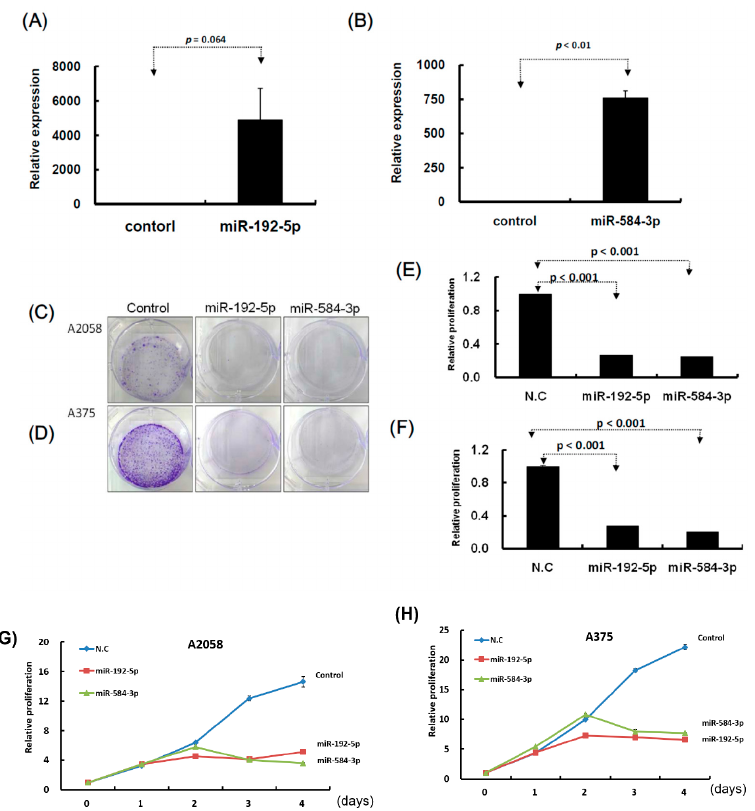
Figure 4. Growth of melanoma cells was suppressed after transfection of miR-192-5p and miR-584-3p mimics candidates. ( A ) and ( B ): After transfection of miRNA mimics, the relative expression levels of miR-192-5p and miR-584-3p were examined through real-time PCR. ( C ) and ( D ): After miR-192-5p, miR-584-3p, and control, respectively, were transfected into melanoma cells, the cells were incubated for two weeks and the colony was examined with crystal violet. ( E ) and ( F ): Relative colony formation ability was quantified using OD595 nm. ( G ) and ( H ): Proliferation of melanoma cells with or without miR-192-5p or miR-584-3p overexpression was examined on four consecutive days using the CellTiter-Glo One solution